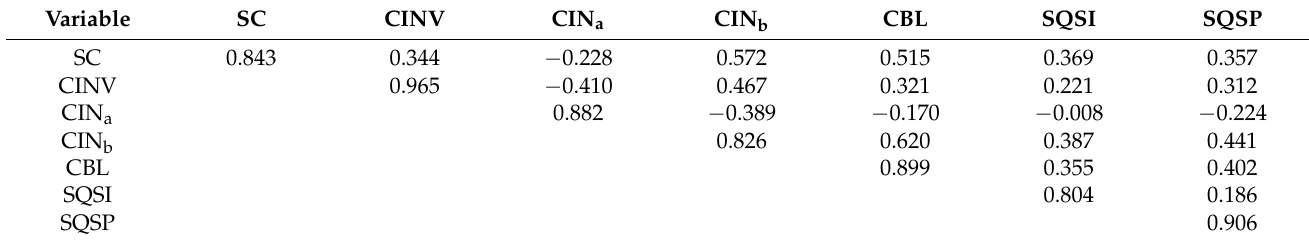
Table 7. Inter-correlation of variables